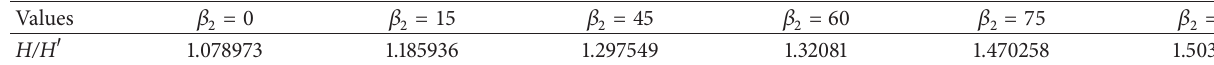
Table 4: Effect of breakwater slope on H / H 󸀠 ratio.